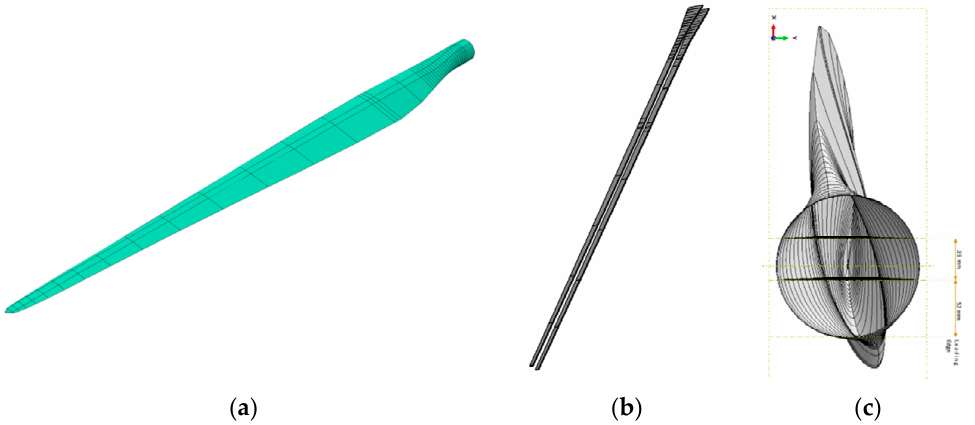
Figure 11. The radial distribution of the nondimensional thickness for the Blue Growth Farm model.